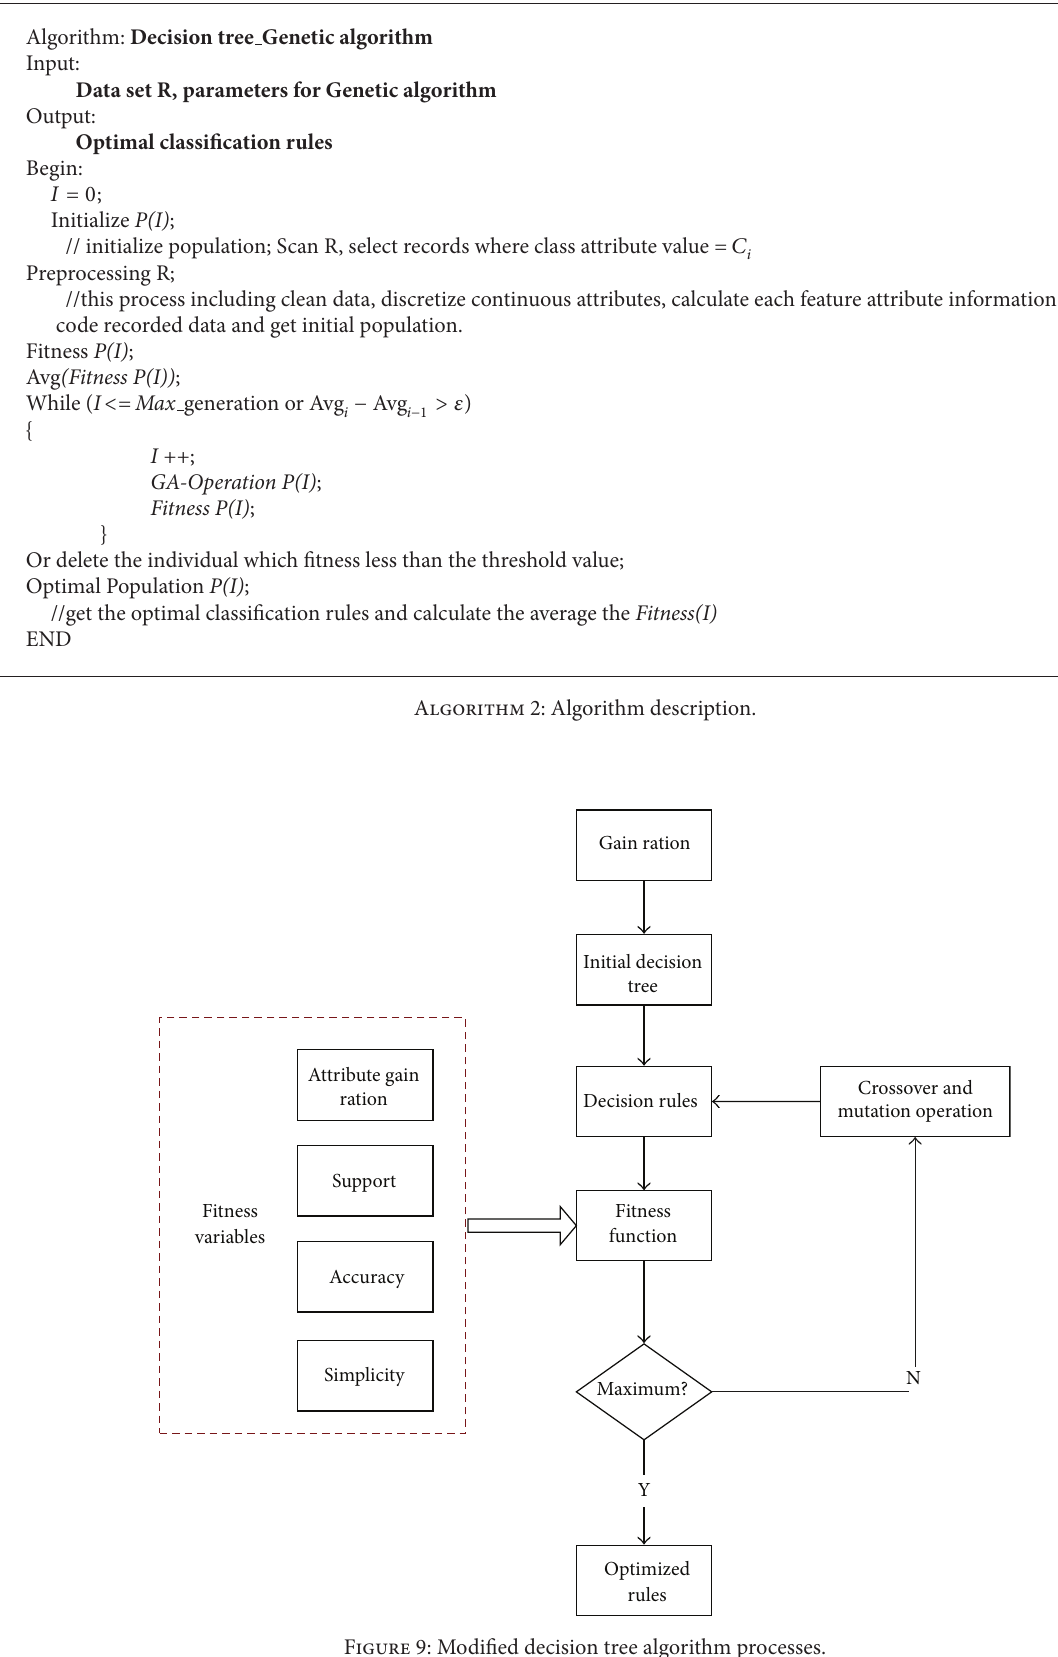
Figure 9: Modified decision tree algorithm